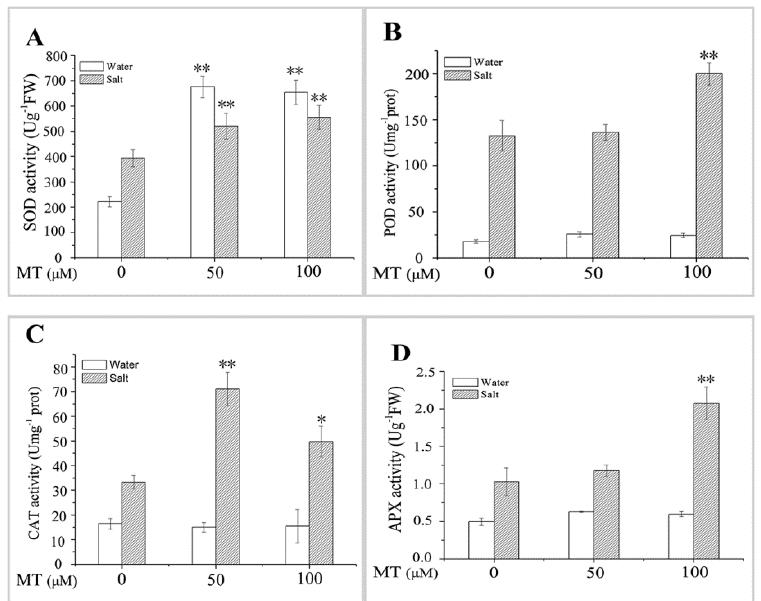
Figure 4. Effect of pretreating with different concentrations of melatonin (MT) on the antioxidant enzyme activities of leaves of naked oat seedlings under salt stress. ( A ) Super oxide dismutase (SOD); ( B ) peroxidase (POD); ( C ) catalase (CAT); ( D ) ascorbate peroxidase (APX). Values are mean ± standard deviation ( n = 3). 0, 50, and 100 represent MT concentration ( µ M) in Figure 4. Asterisks; * and ** indicate significant difference ( p < 0.05 and p < 0.01) compared with mock coating (0 µ M). Measurement was carried out after six days of the salt plus MT pretreatmemt.